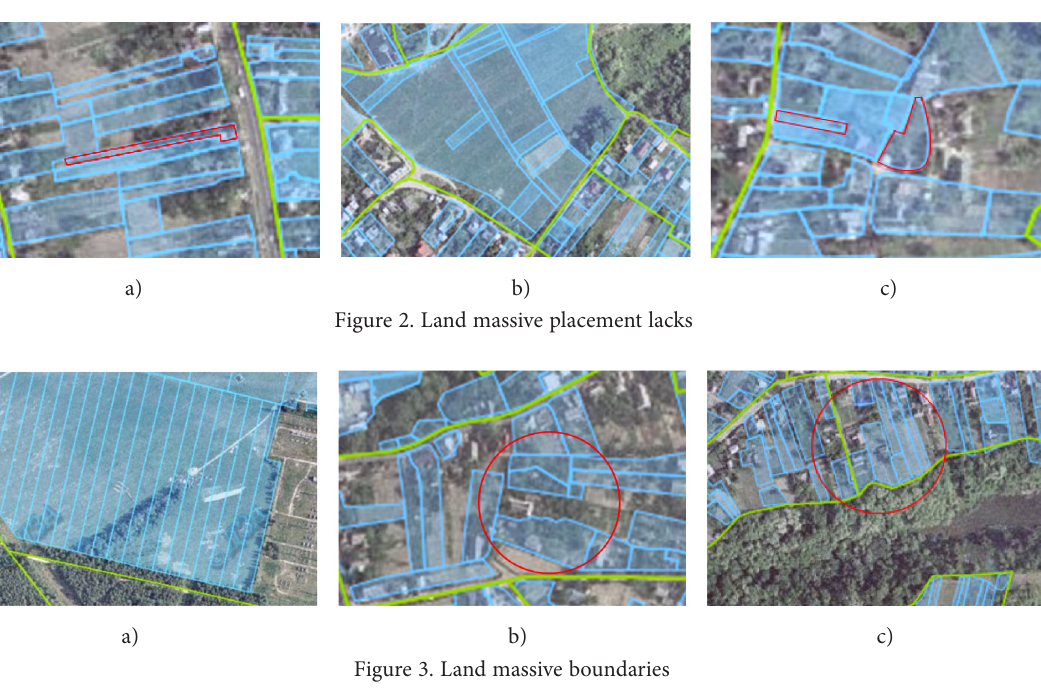
Figure 1. The peer exchange of land as part of inter-economic land management in Ukraine